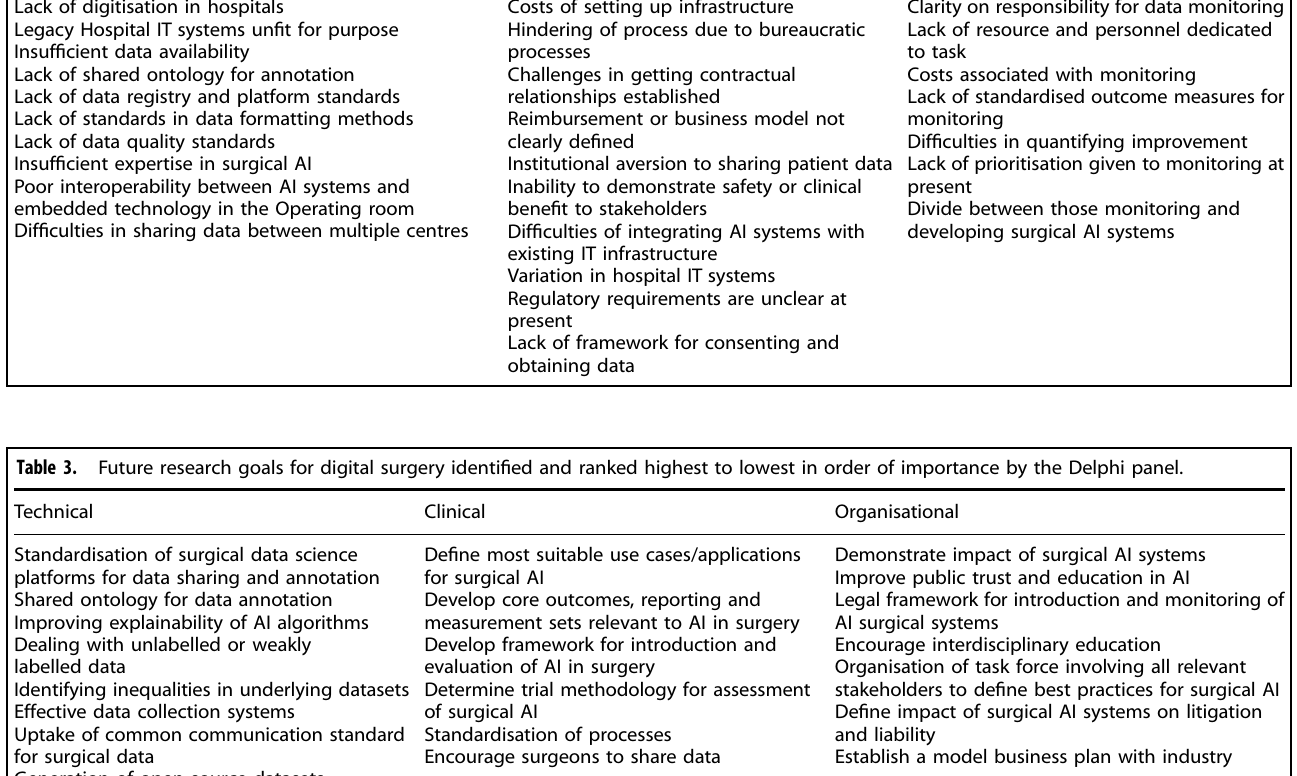
Table 2. Barriers to digital surgery identi fi ed and ranked highest to lowest in order of importance by the Delphi panel. Development Deployment Monitoring